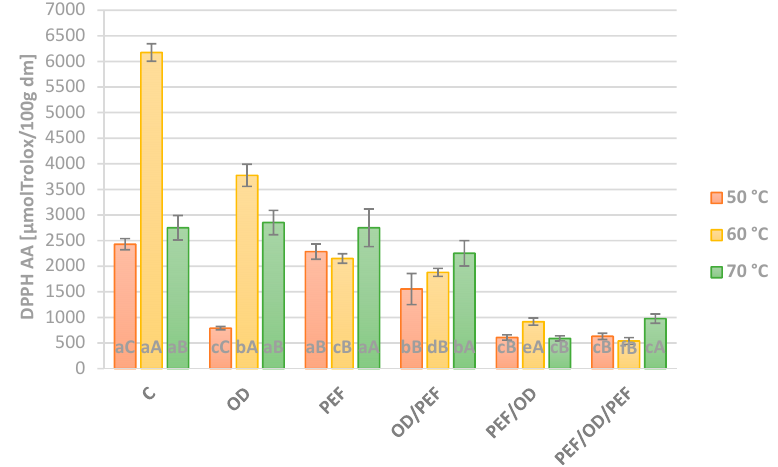
Figure 3. Antioxidant activity (AA) by DPPH assay of untreated and di ff erently pre-treated kiwifruit snacks dried at the temperatures of 50, 60 and 70 ◦ C. Di ff erent lowercase letters indicate significant di ff erences ( p < 0.05) between all considered samples at each drying temperature, while capital letters indicate significant di ff erences ( p < 0.05) between each sample at the three drying temperatures. However, AA measured with the ABTS method (Figure 4) showed the highest values, from 3261 to 4727 μ molTrolox/100 g dm, in PEF and OD/PEF kiwifruit samples dried at all three drying temperatures. Conversely, the lowest values were observed for OD chips dried at 50 and 60 °C and for C, OD, PEF/OD and PEF/OD/PEF kiwifruit samples dried at 70 °C.